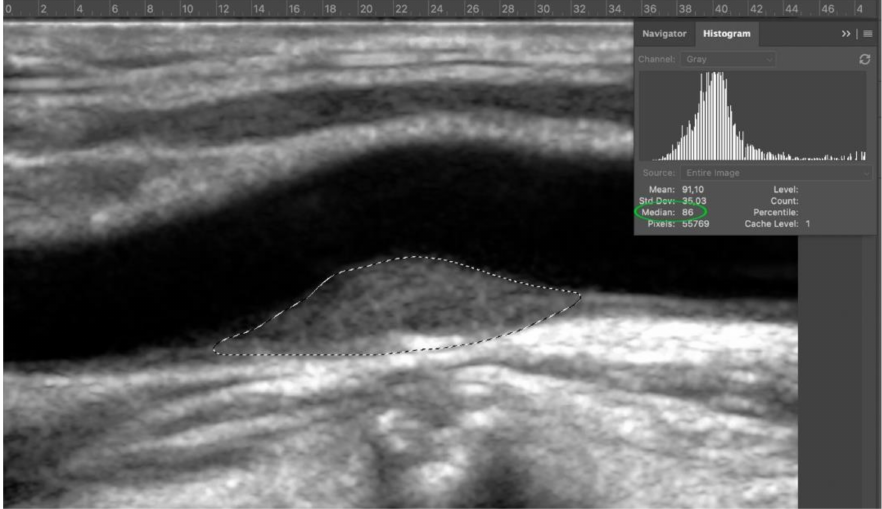
Figure 5. Step 4: grey scale median (GSM) of target plaque. In the example, the GSM is 86 (green